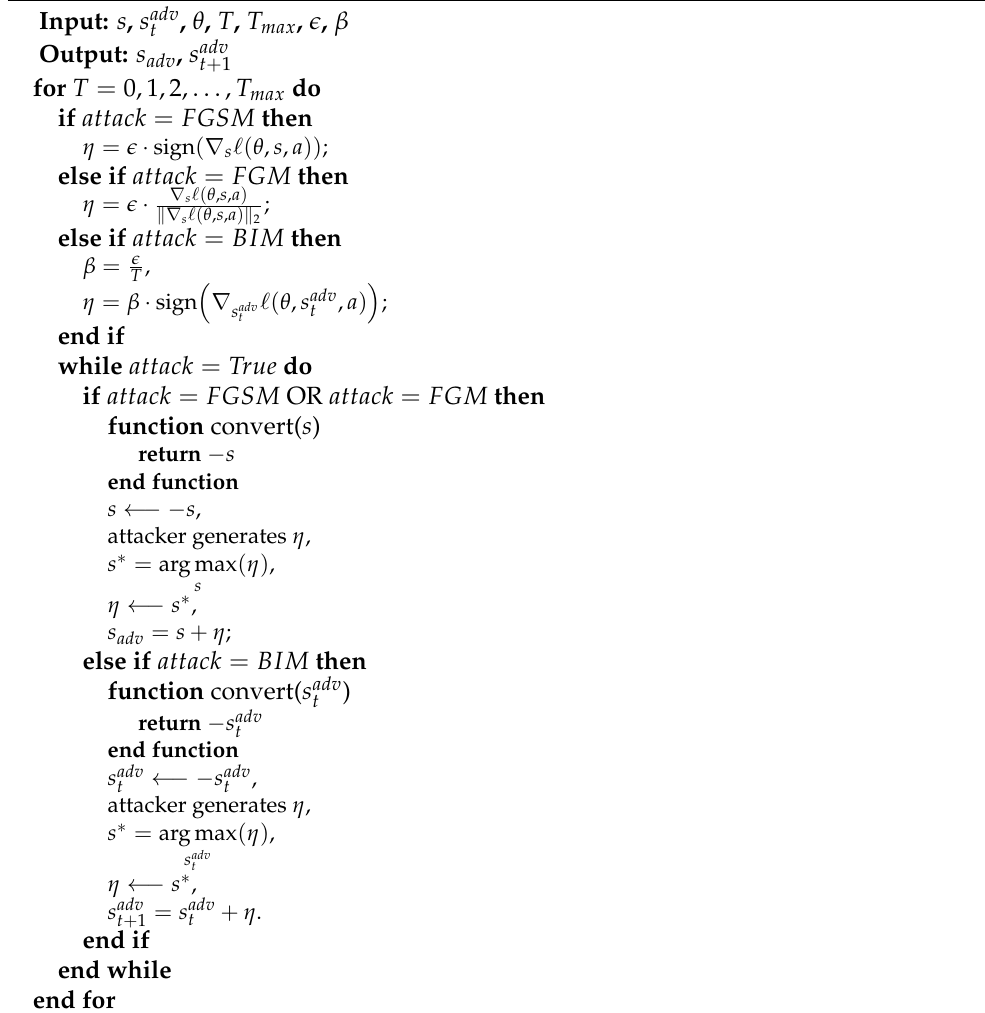
Algorithm 2 Second Adversarial Attack